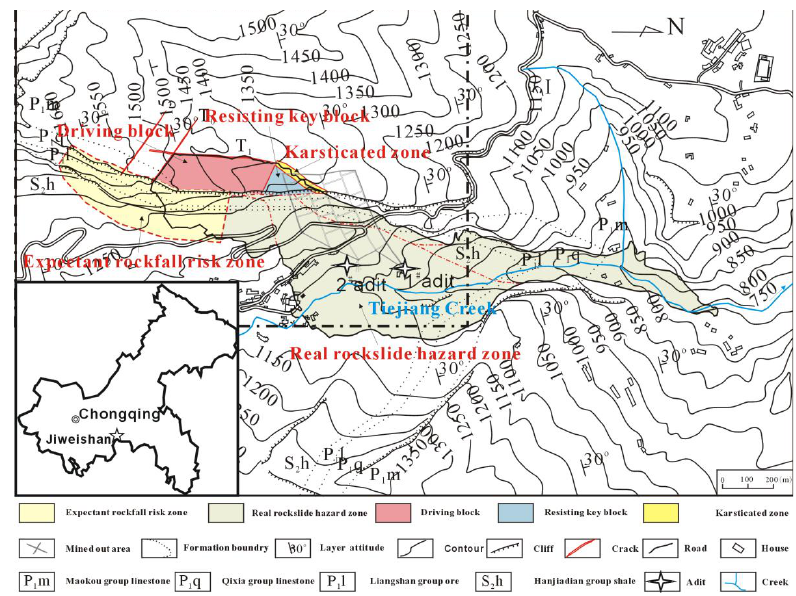
Fig. 1. Geomorphological map of the Jiweishan range, Chongqing Municipality, China. The Jiweishan rockslide is divided into a driving block and a resisting key block. Expectant rockfall risk zone and real rockslide hazard zone are superimposed. The SAR data cover the whole map and are used for co-slide and post-slide analyses as shown in Figs. 7 to 8, while the data cover up (left dashed rectangle) are used for pre-slide analyses as shown in Figs. 4 to 5. The inset is a sketch map of Chongqing Municipality, showing the relative location of the Jiweishan range.